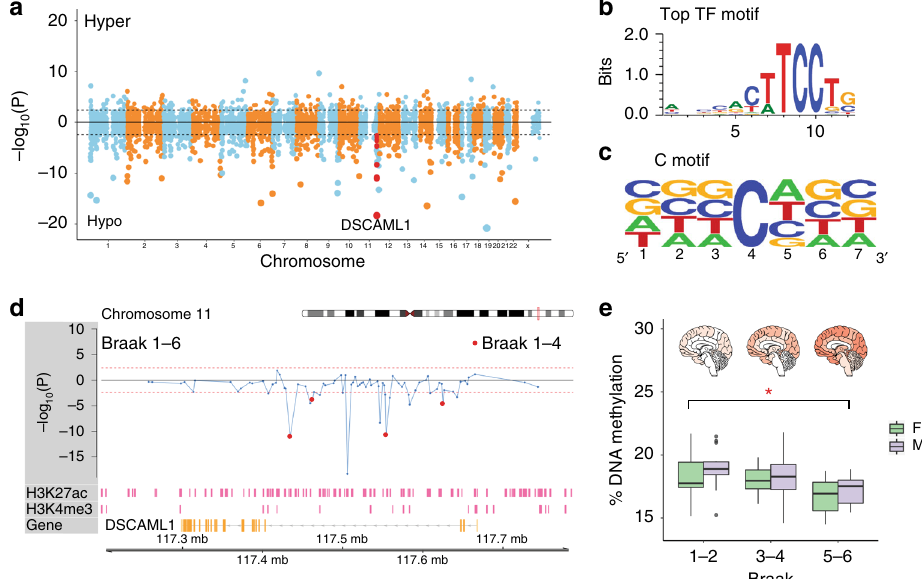
Fig. 1 Fine-mapping of DNA methylation changes at enhancers, genome-wide, in AD neurons. In prefrontal cortex neurons of individuals with no/mild, moderate, and severe AD neuro fi brillary tangle pathology (Braak stage 1 – 6; n = 101 individuals), DNA methylation was pro fi led at enhancer and promoter regions across the genome using bisul fi te padlock probe sequencing. a Manhattan plot showing differentially methylated regions associated with the severity of neuro fi brillary tangle pathology, after controlling for sex, age, postmortem interval, and neuronal subtype proportion. − log 10 (P) refers to the signi fi cance of differentially methylated cytosine enrichment at enhancers, with the sign corresponding to the direction of methylation change (hyper or hypomethylated). Threshold for genome-wide signi fi cance (dashed line) is q < 0.05. Enhancers in DSCAML1 highlighted in red. b Image of ETS motif, the most strongly overrepresented TF motif within the differentially methylated enhancers in AD ( p < 10 − 18 , binomial distribution model in oPOSSUM). Motif sequence logo is provided by MotifMap 80 . c Contribution of CpG and CpH sites to DNA methylation differences at enhancers in AD. Motif analysis depicts a predominant contribution of CpH sites, especially CpA. d DNA methylation changes at enhancer regions in the DSCAML1 gene in neurons that correspond to the severity of AD pathology. Dashed red line is genome-wide signi fi cance threshold ( q < 0.05). Red dots denote enhancers that were also differentially methylated before the arrival of neuro fi brillary tangles in the prefrontal cortex (Braak 1 – 4). Tracks for neuronal (NeuN + ) H3K27ac and H3K4me3, from PsychENCODE (pink, n = 9 individuals) are shown. e Averaged % DNA methylation across Braak stage for the most signi fi cantly